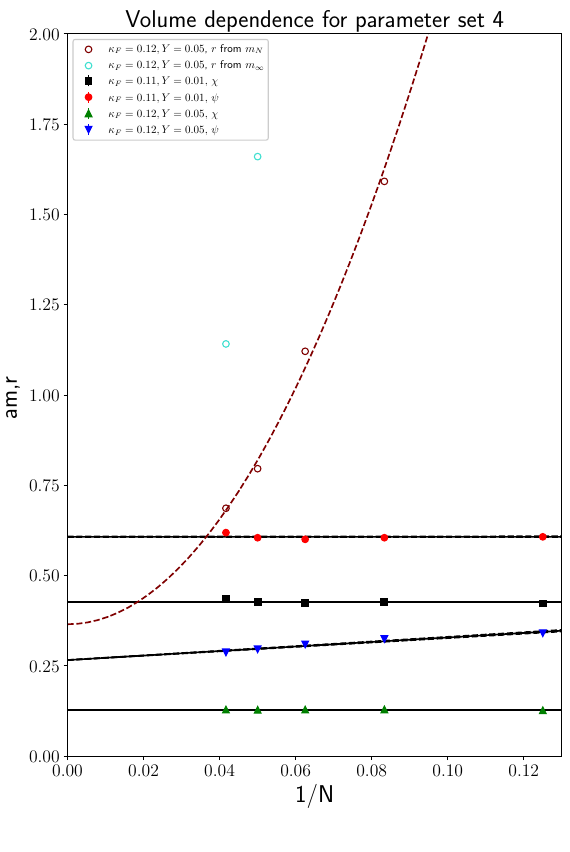
Figure 7: The volume dependence of the masses and r for the parameter set 4 for different values of κ two different Y values. The value of r is only shown if substantial mixing occurs. For the masses a fit of type (31) is also